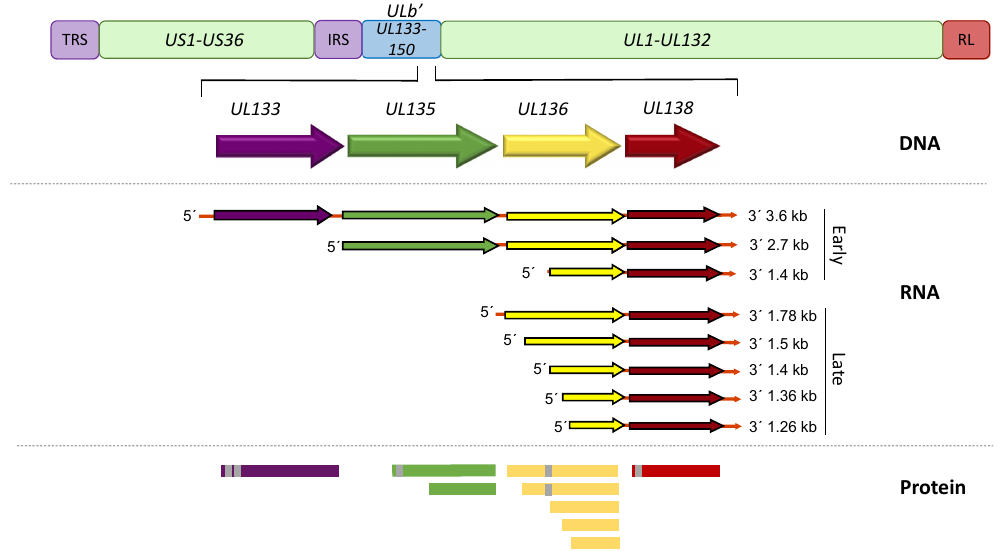
Figure 1. A schematic depiction of the HCMV UL133-UL138 gene locus. The UL133-UL138 gene locus, located within the UL b ’ region, is present in clinical isolates and low passage viruses but lost in serially passaged laboratory strains. The 3 major transcripts that accumulate at early times of infection or additional transcripts encoding UL136 and UL138 that accumulate at late times of infection in fibroblasts are depicted. Alternative transcription / translation initiation sites lead to at least 2 UL135, 5 UL136 and 2 UL138 isoforms. Area shaded grey indicated putative or confirmed transmembrane